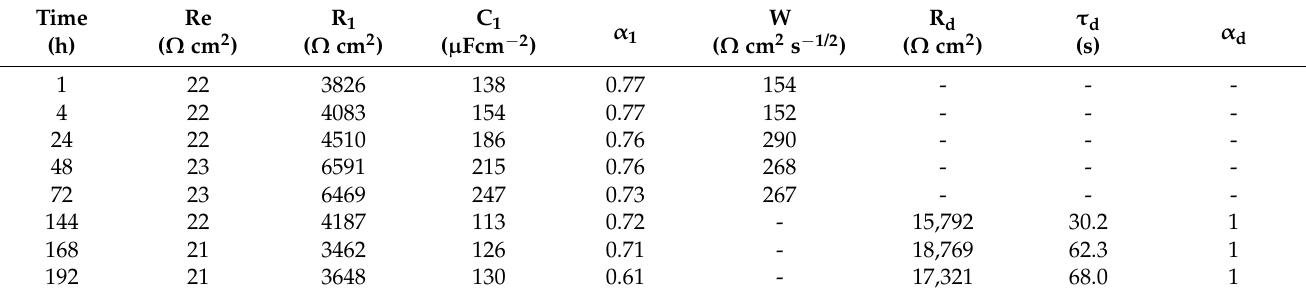
Table 6. Values of the fitting parameters for a BR (annealed) sample at different immersion times in the chlorinated